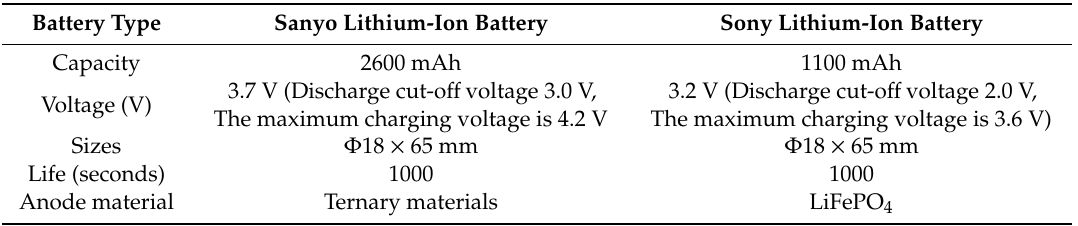
Table 1. Detailed battery